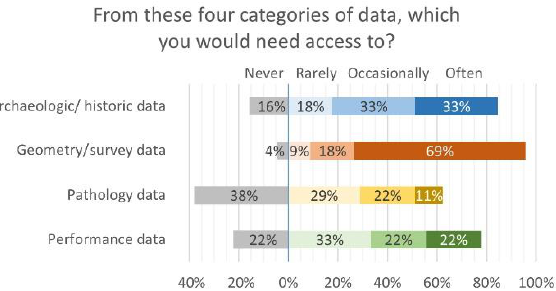
Figure 17: Responses of all heritage sector participants for data categories they need access to.